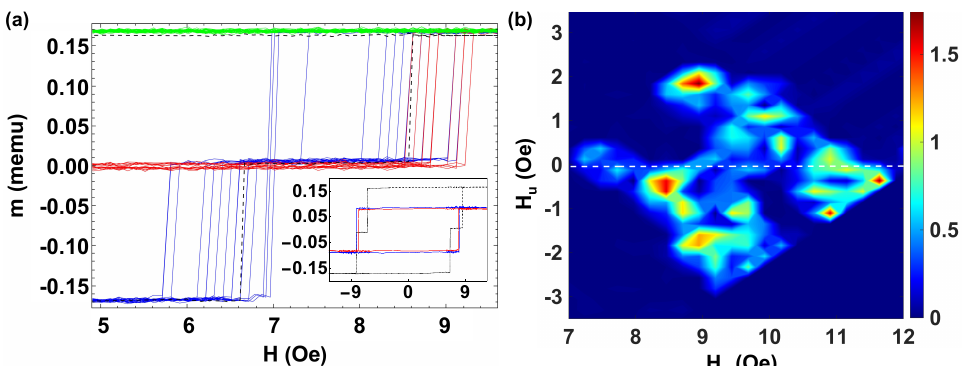
Figure 4. ( a ) FORC curves for two quasi-identical Fe 77.5 B 15 Si 7.5 bistable amorphous microwires. The inset shows the MHLs for individual measurements: the red and blue lines correspond to the MHLs of the individual isolated microwires, while the dashed black line corresponds to the MHL when both wires are placed together. ( b ) Corresponding FORC diagram for the set of the two quasi-identical